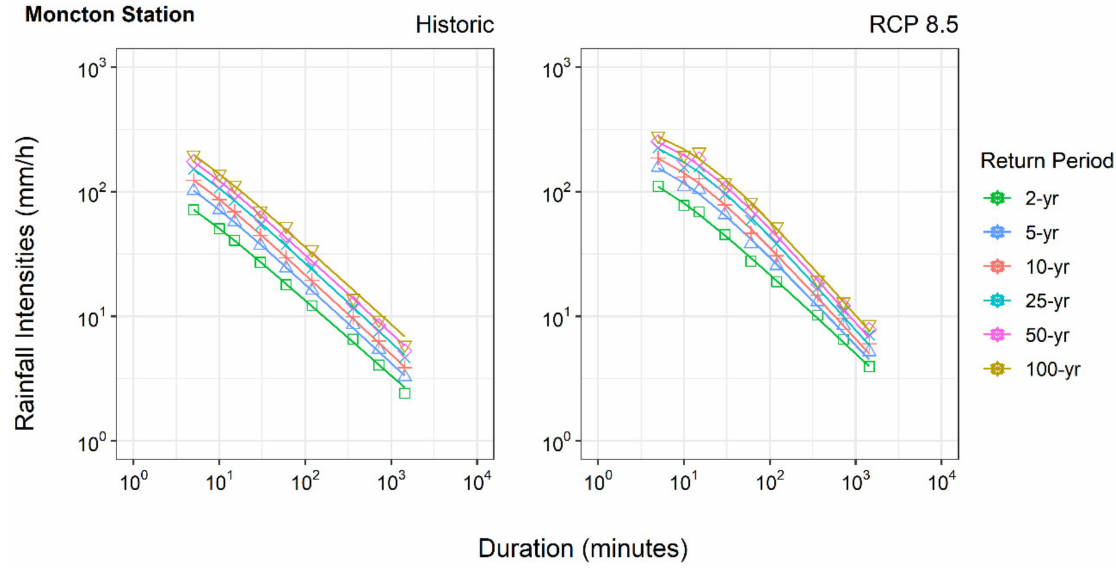
Figure 8. Rainfall intensities, in mm/h, estimated for the multimodel ensemble for the Moncton station. X-axis is duration of precipitation in minutes, and Y-axis is the intensity of precipitation in